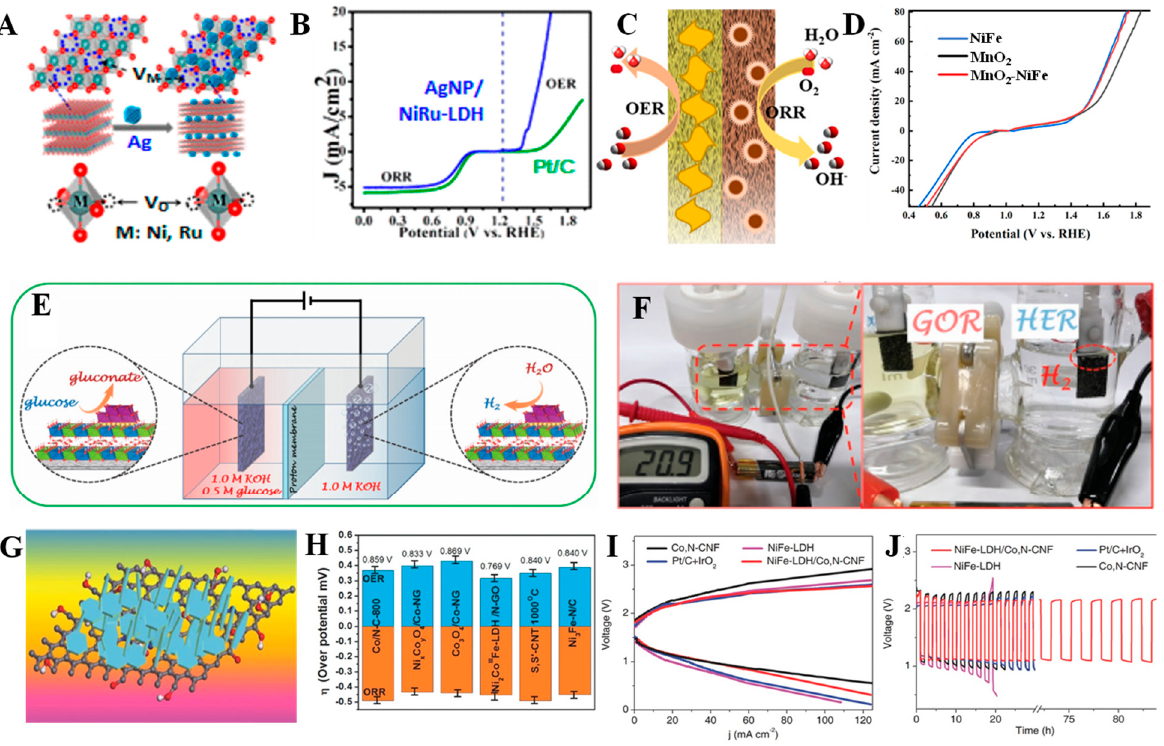
Figure 14. ( A ) Formation of metal/oxygen vacancies (VM, VO) in LDHs; ( B ) Bifunctional catalytic activity of Ag NP/NiRu- LDHs and commercial Pt/C catalysts toward ORR/OER activities at 1600 rpm in 0.1 M KOH electrolyte [216]. Copyright © 2018 American Chemical Society. ( C ) Schematic illustration of the selective growth for the fabrication of Janus MnO 2 - NiFe /Ni with the assistance of Vaseline. ( D ) OER and ORR polarization curves of air electrodes at 1600 rpm in 1 M KOH